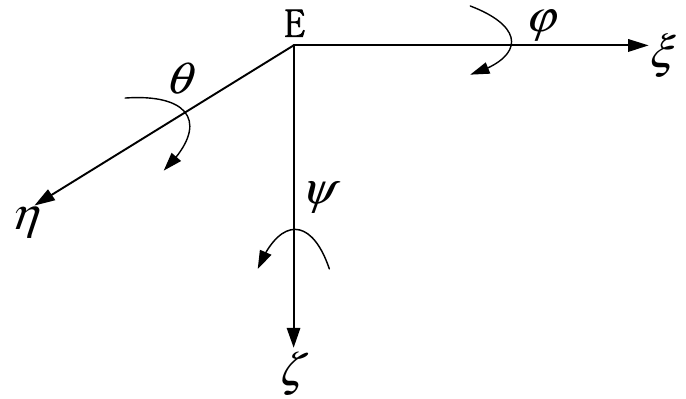
Figure 1. Inertial coordinate system.